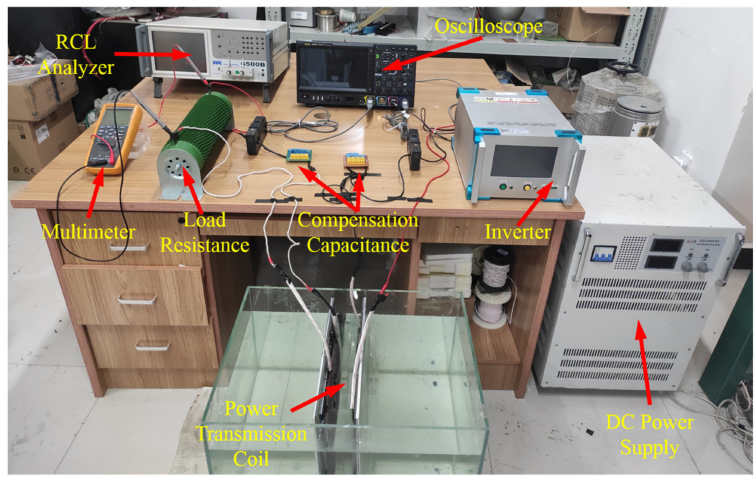
Figure 14. The experiment